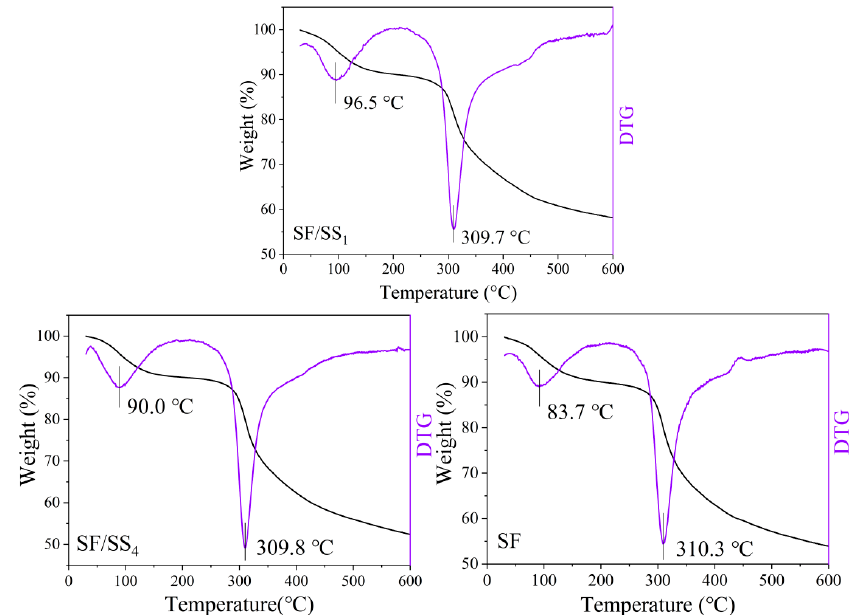
Figure 11. TG-DTG curve of SF/SS composite film after mineralization for 7 d.